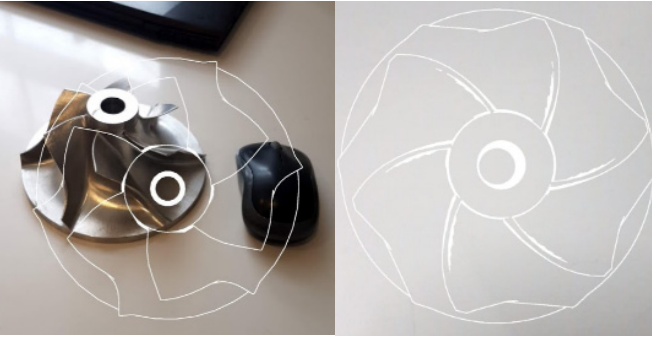
Table 1. Natural frequencies for the aluminum impeller.